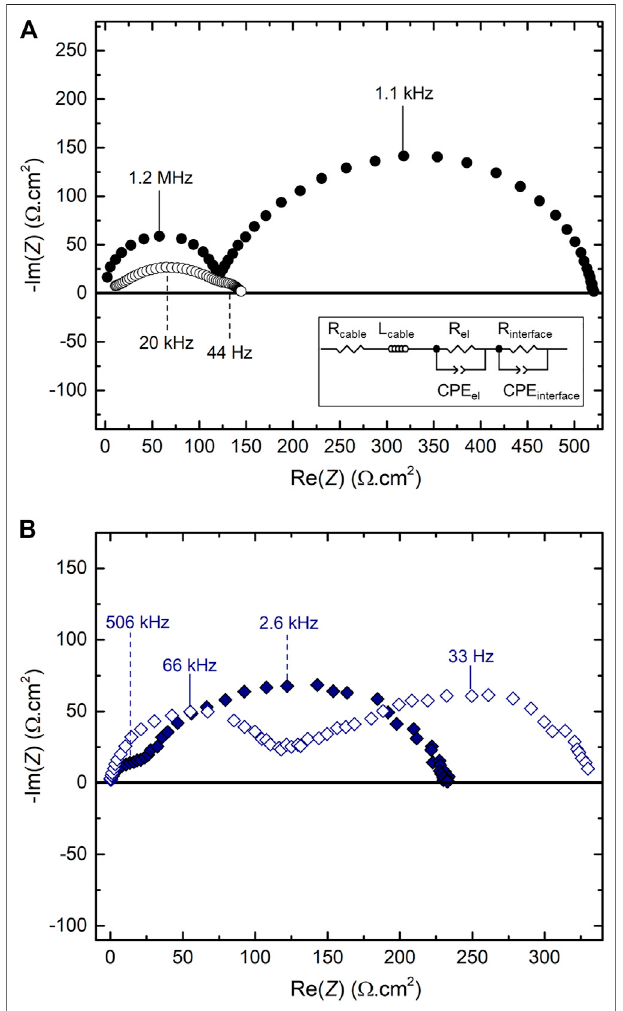
FIGURE2| Impedance spectrarecorded at 25 ° Coftheelectrochemical cells ( fi lled symbols) before and (open symbols) after cycling for (A) Cell_ A and (B) Cell_ B . The inset in (A) shows the electrical equivalent circuit used to fi t all the spectra.